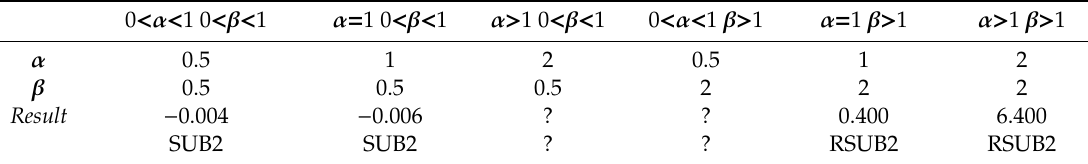
Table 2. Example of the delay e ff ect according to the values of α and β . Source: Own elaboration.